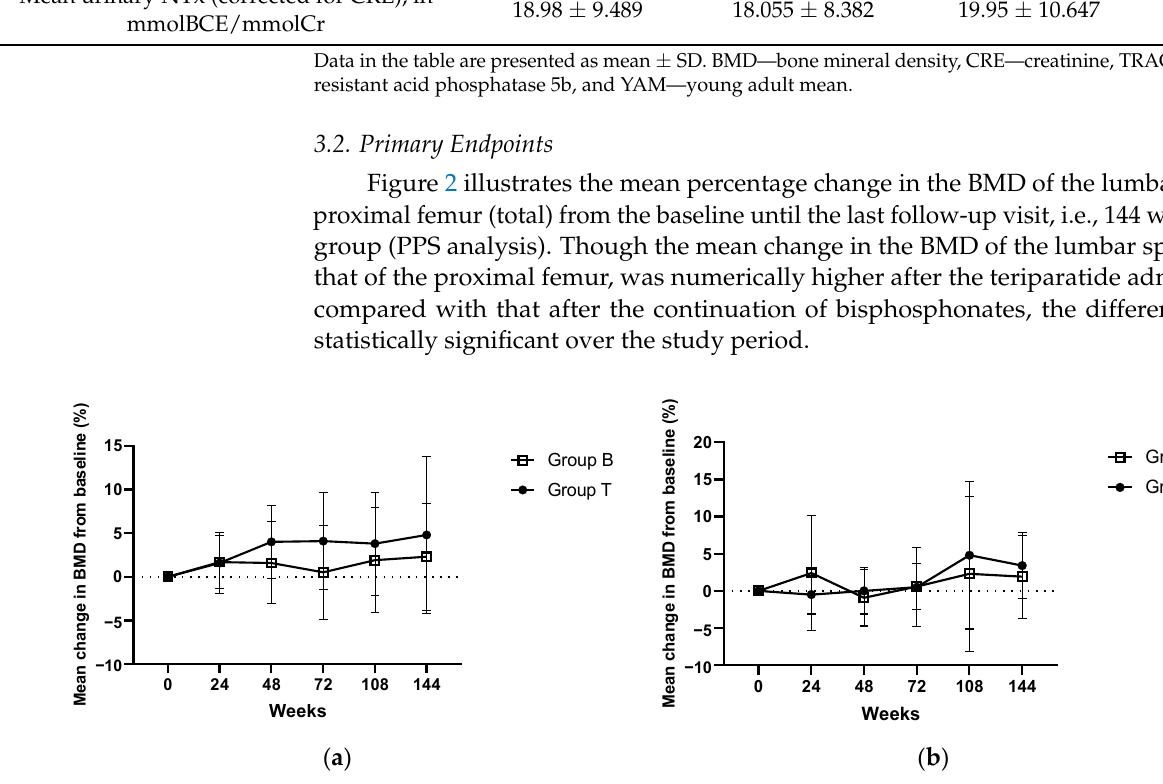
Figure 2. Mean change in BMD for: ( a ) lumbar spine (L1–L4) and ( b ) proximal femur (total) from baseline to 144 weeks for the treatment groups in the PPS. BMD, bone mineral density; Group B, bisphosphonate group; Group T, teriparatide group; PPS, per ‐ protocol population. The primary endpoint, the mean percentage change in the BMD of the lumbar spine (L1–L4) after 72 weeks of treatment from the baseline in the PPS population, was 0.5 ± 5.4% in Group B and 4.1 ± 5.6% in Group T ( p = 0.209). Although there was a trend toward a higher BMD in Group T compared to Group B, the difference was not statistically sig ‐ nificant. There was no apparent intergroup difference in the mean percentage change in the proximal femur (total) BMD (0.6 ± 3.1%, Group B vs. 0.5 ± 5.3% Group T; p = 0.572) at week 72 (Table S1).